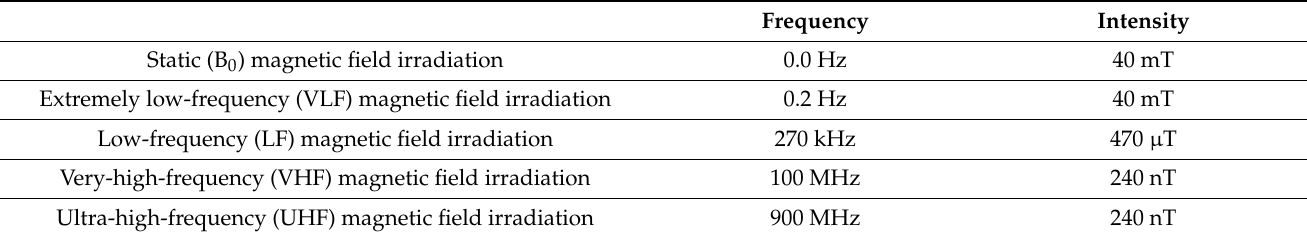
Table 1. Main radiation characteristics associated to the static, low-, and high- (radio) frequency magnetic fields used in this work.